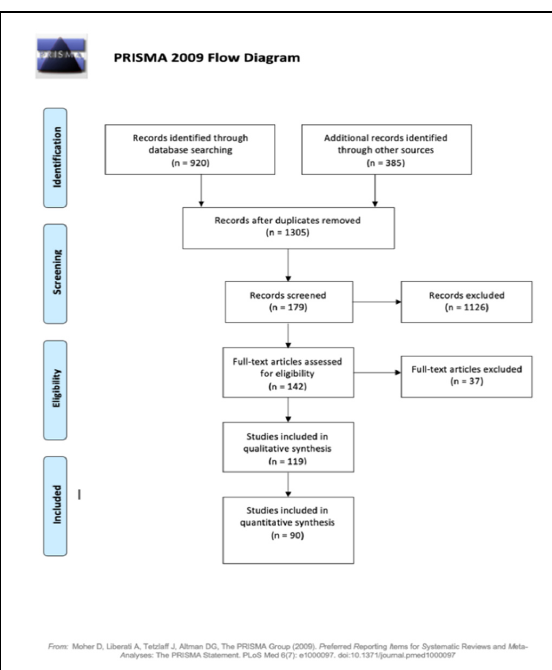
Figure A1. PRISMA flow diagram describing the selection of studies for review [88].